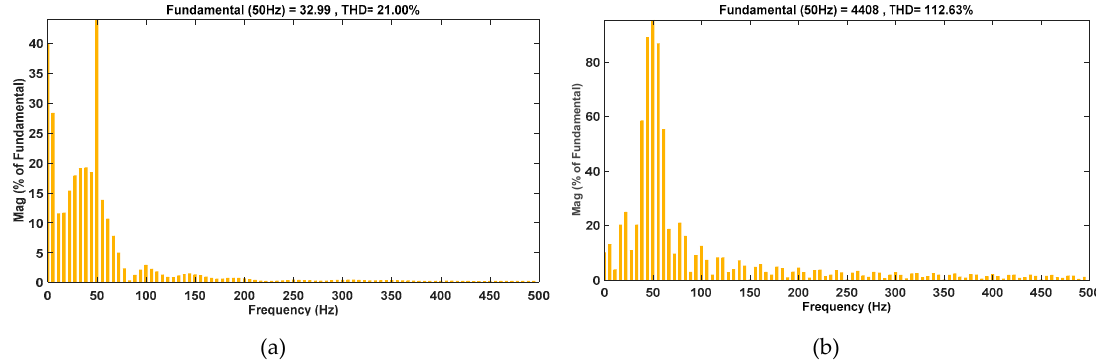
Figure 14. THD with LM controller for grid current ( a ) and voltage ( b ) during the P-G fault.